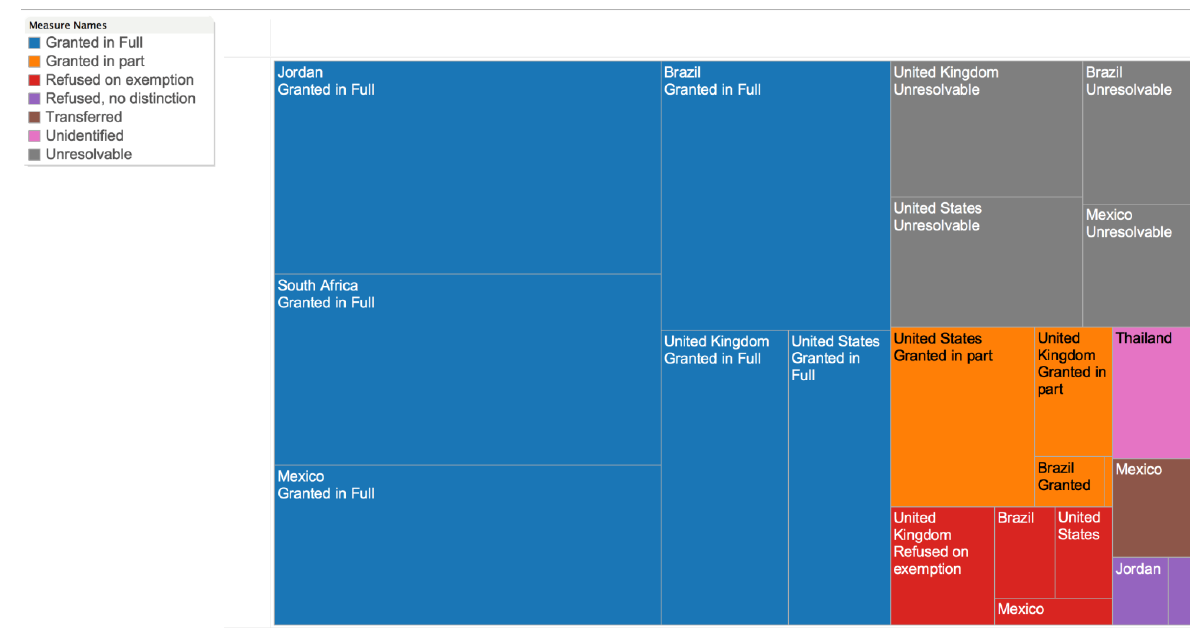
Figure 1: Request Volume and Responses (2012-2013), by Percentage – Treemap View.